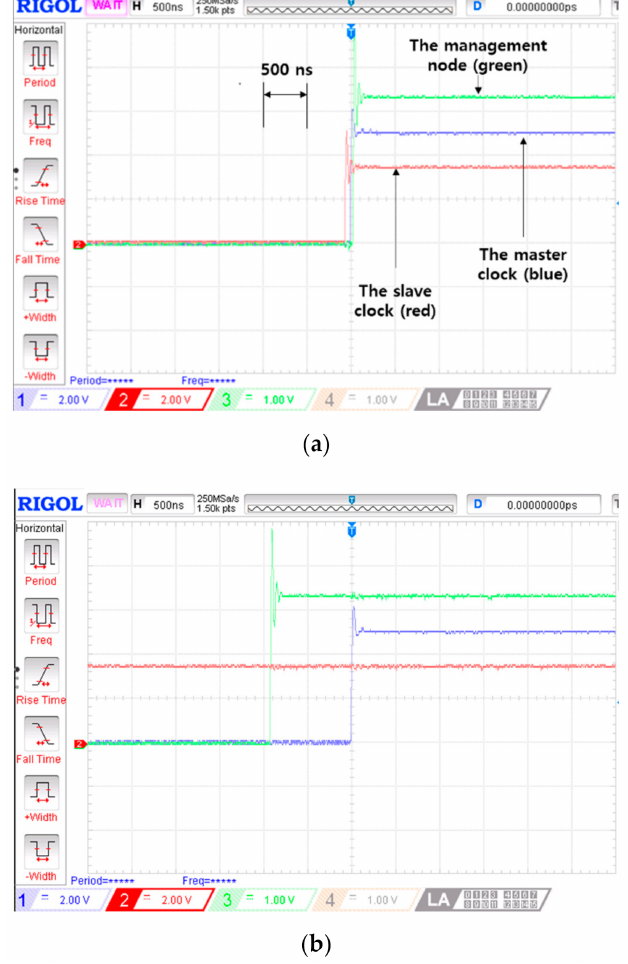
Figure 8. Operation test result of the proposed self-correction. Three 1 pulse per second(PPS) signal comparisons over time after the master failure. ( a ) 0 s (at the time of the master failure occurrence); and ( b ) 124